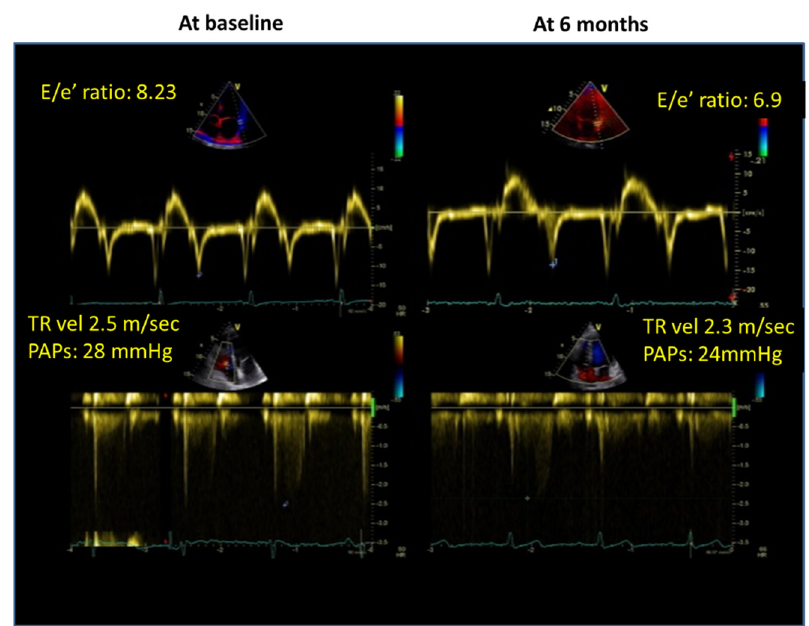
Figure 2. Clinical case of patient undergoing 6 months of tadalafil treatment. Patient’s diastolic function at baseline ( left ) panel and after 6 months of treatment ( right ) panel; from top to bottom: pulsed Doppler velocity on mitral valve, tissue Doppler velocity of the lateral mitral annulus, peak systolic tricuspid jet velocity.